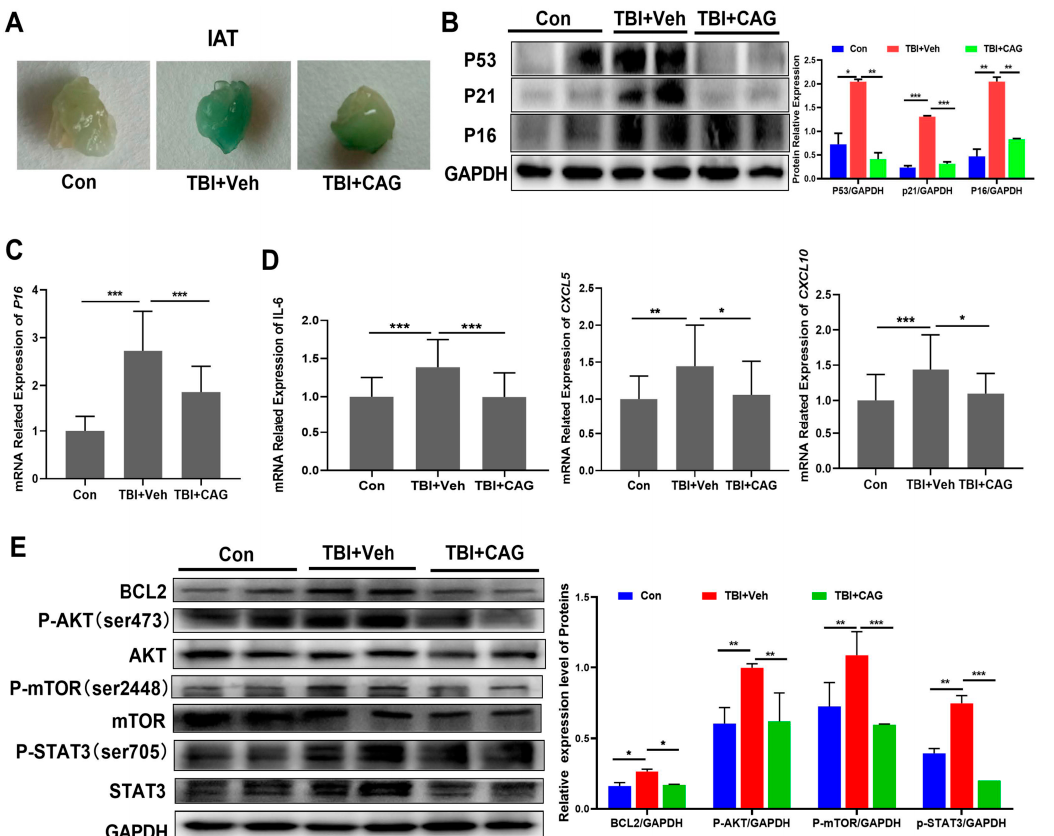
Figure 5. CAG decreases the senescent cell burden and reduces SASP in TBI-aged mice. ( A ) Representative images of SA- β -Gal staining of IAT from young and TBI-aged mice treated with vehicle or CAG. ( B , E ) The protein expression levels of senescence markers ( B ) and apoptosis pathway proteins ( E ) in liver from young and TBI-aged mice treated with vehicle or CAG. ( C , D ) The mRNA expression levels of p16 and SASP in liver from young and TBI-aged mice treated with vehicle or CAG. * p < 0.05, ** p < 0.01, and *** p < 0.001.